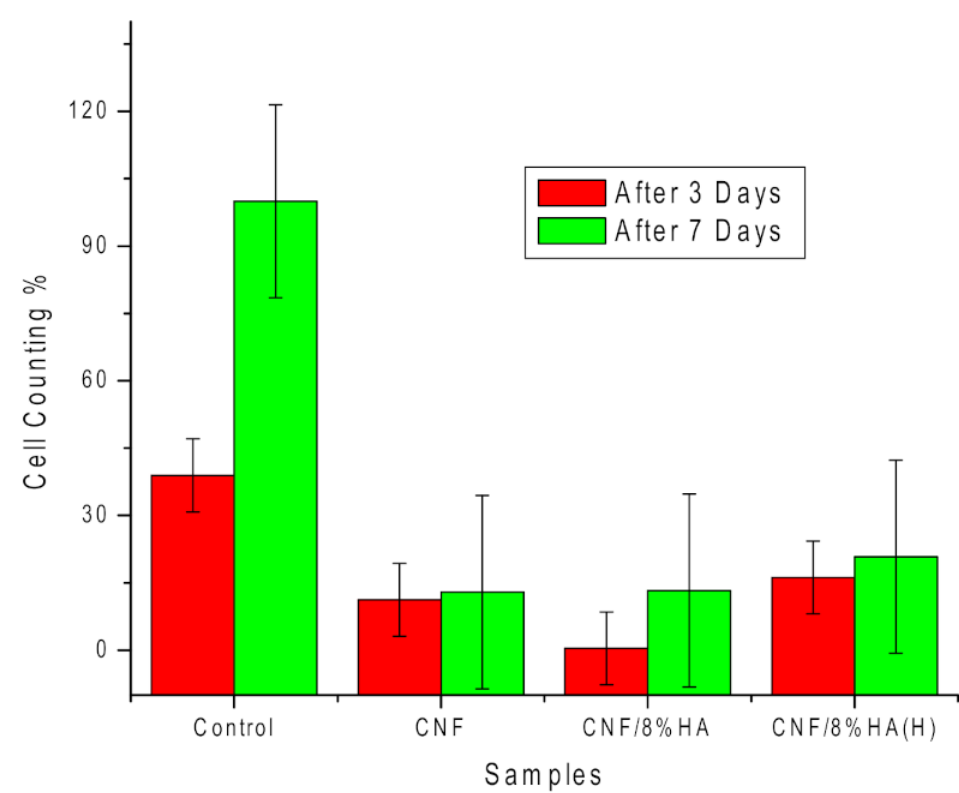
Figure 7. Number of cells attached to the prepared samples (CNF, CNF/8HA, and CNF/8HA (hydrothermally)) in comparison with the control (no sample) after three days (red columns) and seven days (green